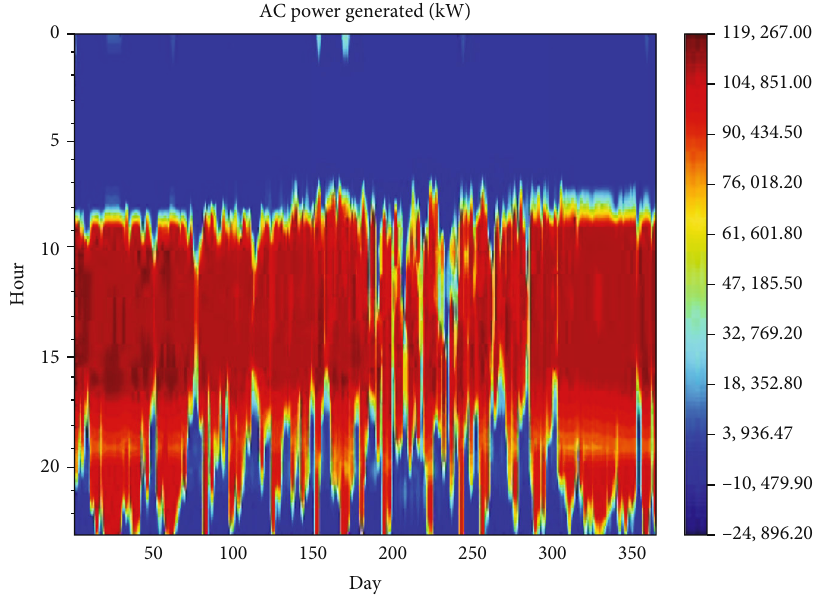
Figure 8: Net electricity to the grid in year